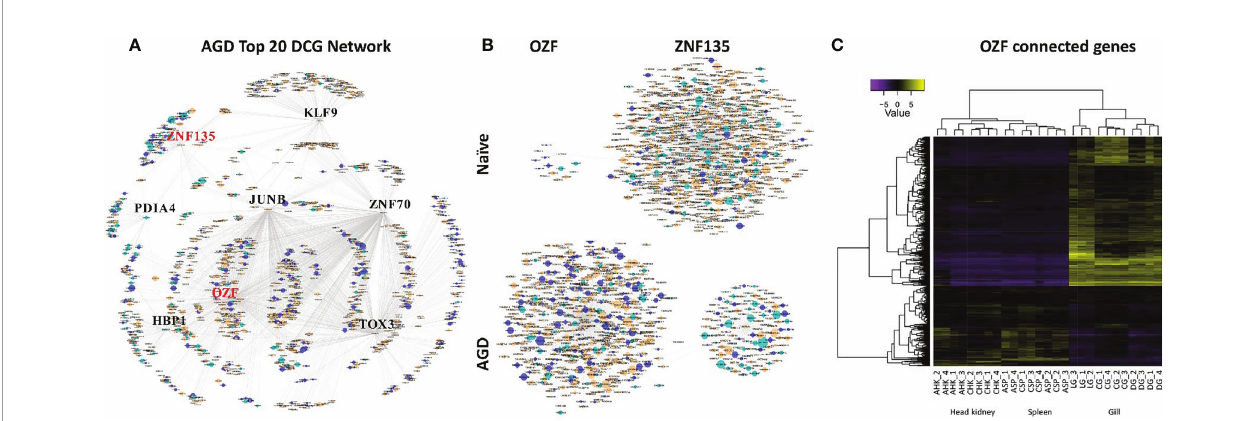
FIGURE 3 | Sub-networks for the top differentially connected genes (DCGs) likely to regulate the transcriptomic response during amoebic gill disease (AGD) in Atlantic salmon. (A) AGD network of 8 transcription factors (TFs) among the top 20 DCGs using the PCIT algorithm. All nodes are represented by ellipses except for genes coding key regulators (TFs) which are diamond shaped. Nodes are orange for gill, green for head kidney and purple for spleen. The size of the nodes is relative to the normalized mean expression values in all samples. (B) Subnetworks of top differentially connected TFs. The networks created with the most differentially connected genes between naïve and AGD-affected networks with zinc fi nger protein OZF-like ( OZF ) as the key regulator with the greatest number of connections in the AGD-affected network, while zinc fi nger 135 ( znf135 ) lost the majority of its connections in the AGD-affected network. (C) Heat map shows hierarchical clustering of differential expression of connected genes (rows) in the OZF network among replicates from a naïve (C) and AGD-affected (A) Atlantic salmon in the head kidney (HK), spleen (SP) and gill (G). The AGD-affected gill data is represented by the lesion (L), a biopsy distal to the lesion (D) and naïve gill (C). Expression values (CPM) are log 2 -transformed and median-centered by